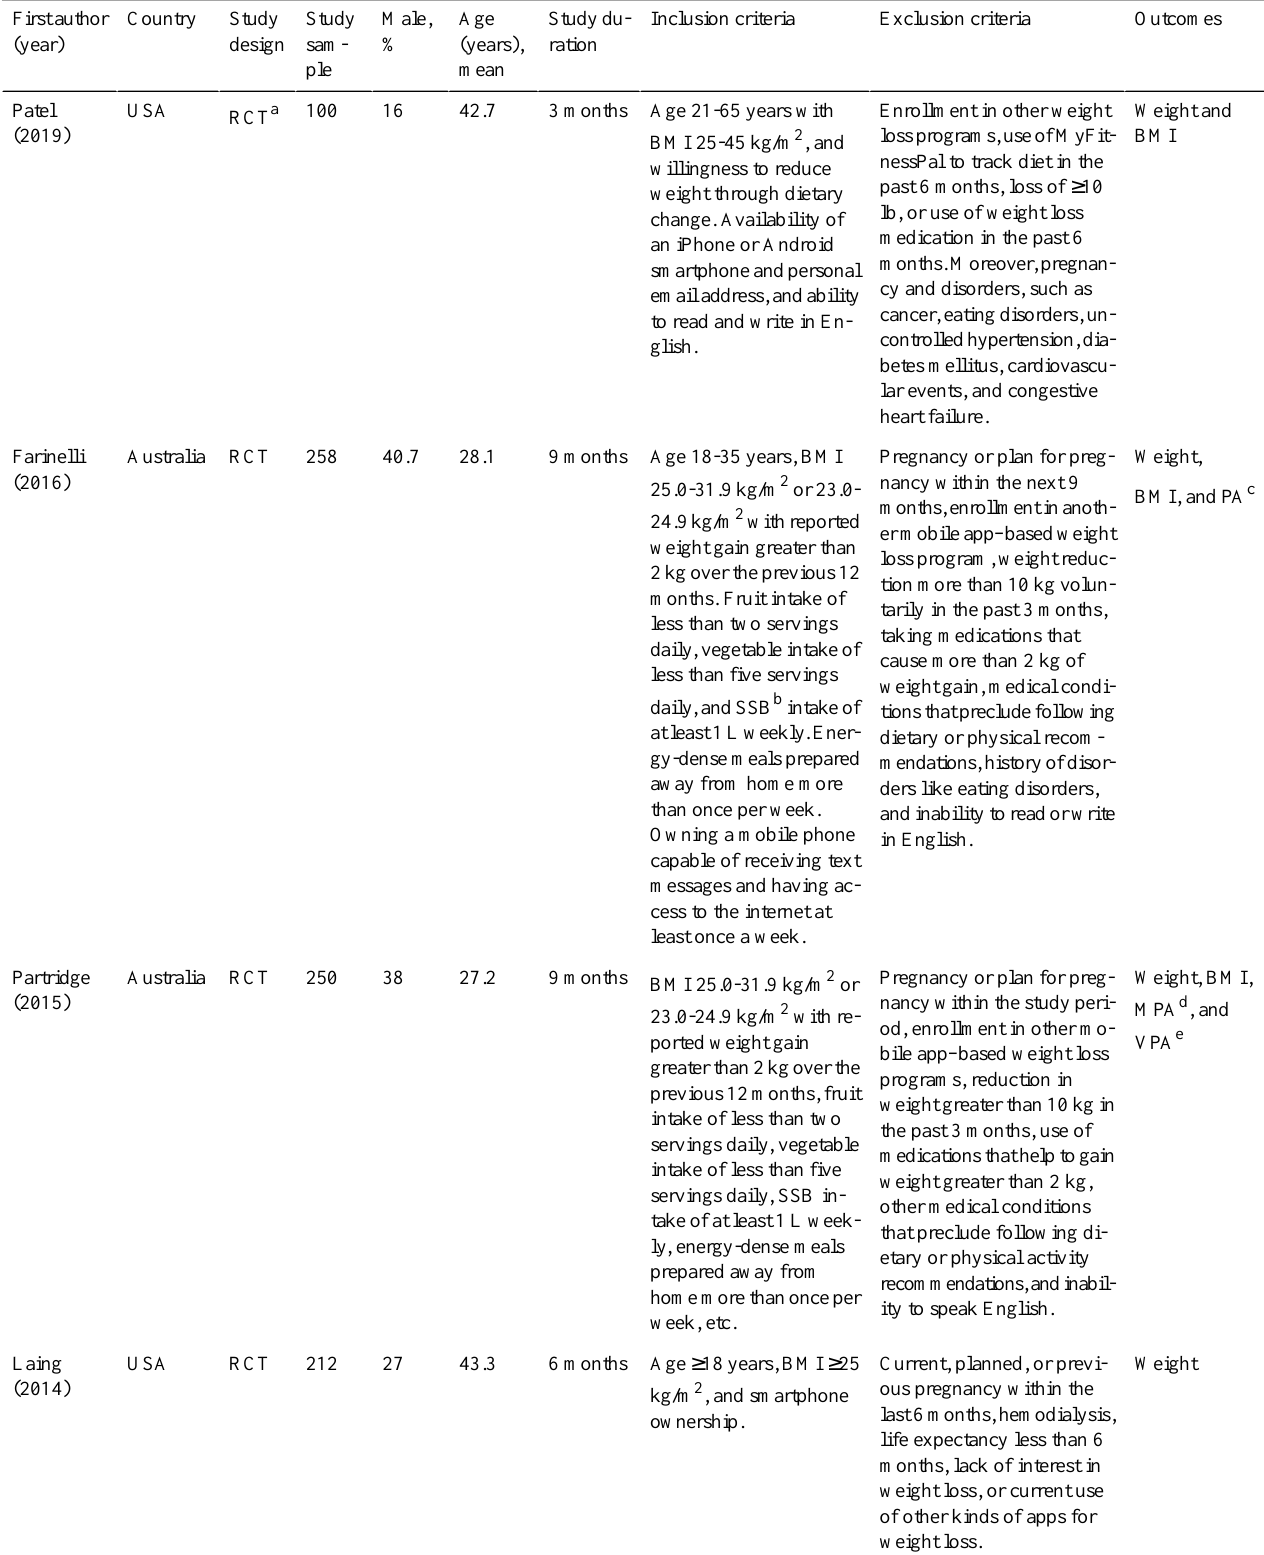
Table 1. Characteristics of the studies included in the